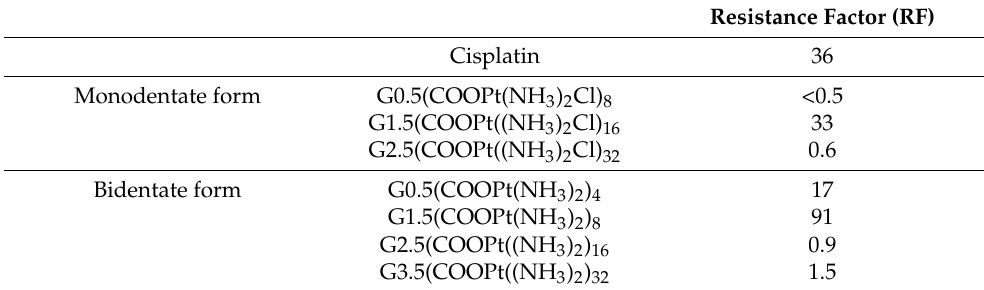
Table 6. Resistance factor for cisplatin and the metallodendrimers